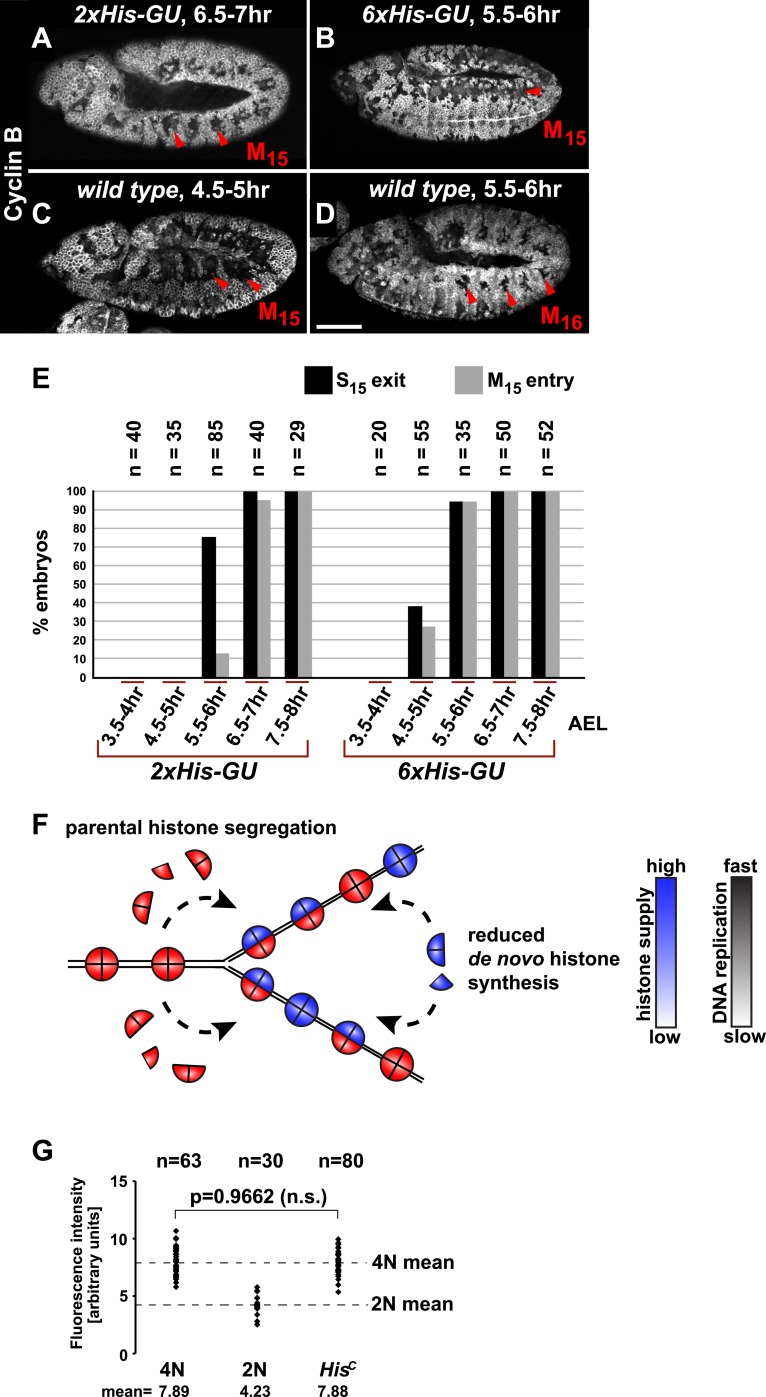
Histone availability determines the rate of S phase progression but is not required for completion of DNA replication.(A–D) Immunofluorescent staining with antibodies against Cyclin B. (A) Cyclin B degradation at 6.5–7 hr AEL around the tracheal pits in 2xHis-GU embryos during M15 (arrowheads) shows that these embryos are lagging more than one cell cycle behind as compared to wild type (see also Figure 3—figure supplement 1). (B) Cyclin B degradation in dorsal cells of 6xHis-GU embryos at 5.5–6 hr AEL during M15 (arrowheads), showing that 6xHis-GU reduced the delay in cell cycle progression compared to 2xHis-GUs (see also Figure 3—figure supplement 2). (C) Cyclin B degradation in dorsal cells of wild type embryos at 4.5–5 hr AEL during M15 (arrowheads). (D) Cyclin B degradation at 5.5–6 hr AEL around the tracheal pits in wild type embryos during M16 (arrowheads). (E) BrdU pulse labelling for 15 min of 2xHis-GU and 6xHis-GU embryos at indicated developmental stages and staining with antibodies against BrdU and Cyclin B. Shown is the quantification of embryos that completed S15 (‘S15 exit’, based on lack of BrdU labelling) and progressed into M15 (‘M15 entry’, based on Cyclin B degradation), showing the interdependence of the number of histone genes and cell cycle progression. n: number of embryos. (F) Schematic model showing nucleosome assembly at the replication fork and its dependence on histone supply. (G) DNA quantification of single nuclei stained with DAPI. Wild type nuclei in G215 and early S16 defined 4N and 2N DNA content, respectively. HisC mutant nuclei show mean intensity value of 4N nuclei, suggesting that mutant cells completed genome duplication. n: number of nuclei, p: probability from Student's t test, n.s.: not significant. Scale bars: 100 µm (A–D).